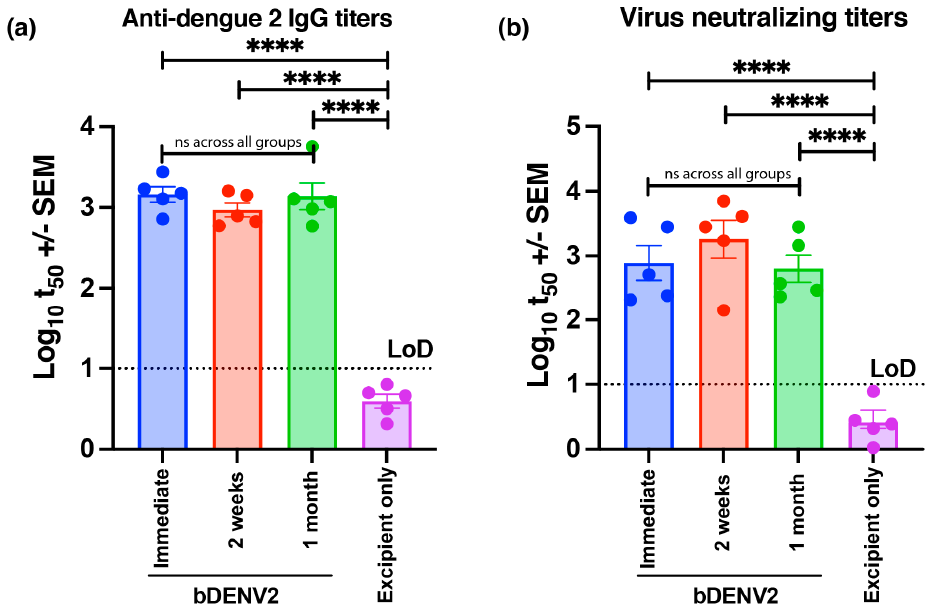
Figure 4. Store and patch study: The delivery of stable bDENV2 via HD-MAP. bDENV2 was coated on the HD-MAP and stored for 2 weeks or a month at 4 °C before being used to vaccinate female BALB/c mice. HD-MAPs freshly coated with bDENV2 or excipient only were included as controls for this study. ( a ) The IgG response for sera taken 21 days post-vaccination was determined, and mid-point (t50) antibody titers were plotted. ( b ) Neutralizing antibody titers were determined for sera obtained 21 days post-vaccination against DENV2 ET00. Note: Each symbol represents a single mouse. The line indicates mean antibody titers with bars showing ± SEM. **** p ≤ 0.0001 assessed by one-way analysis of variance (ANOVA, α -level 0.05).